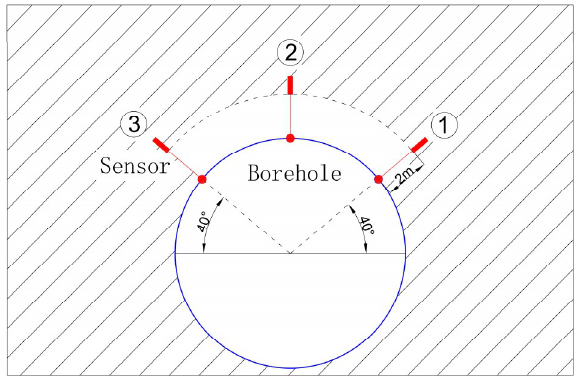
Figure 4. Layout of sensors.